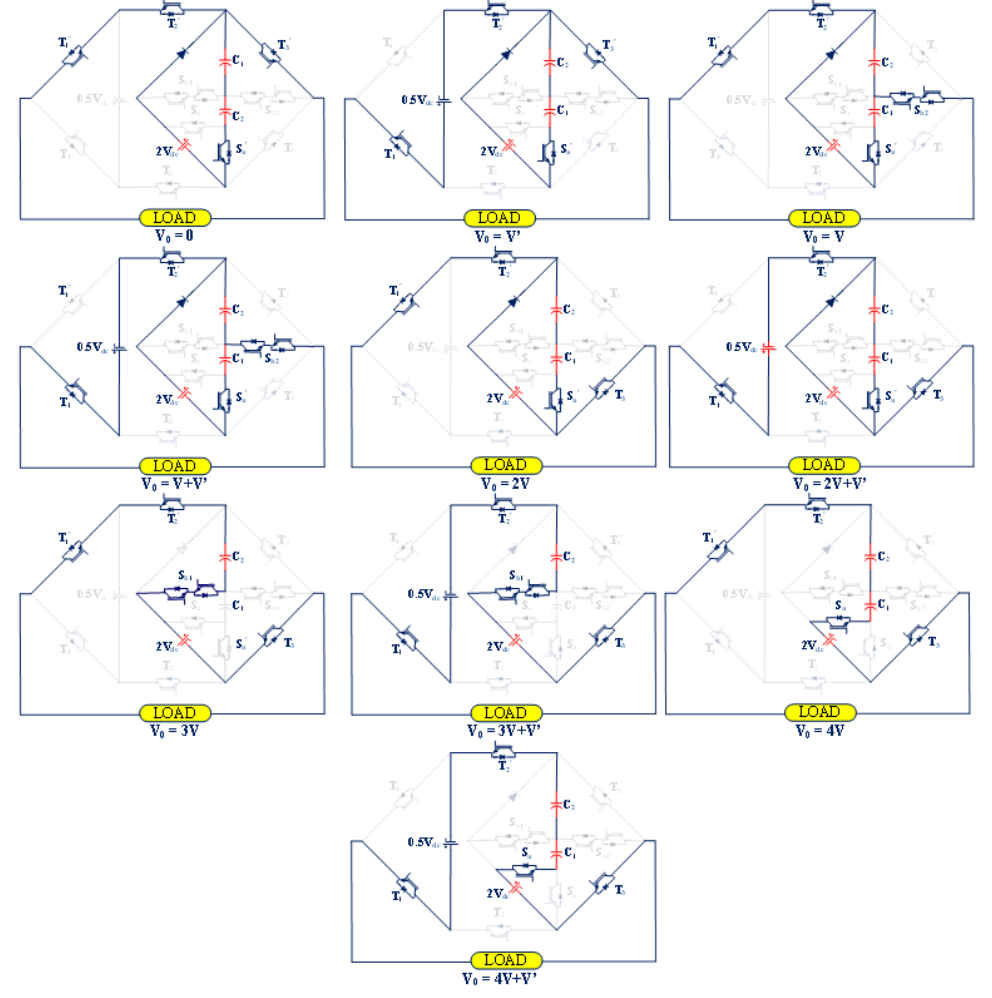
Figure 1. Structure of proposed multilevel inverter topology.